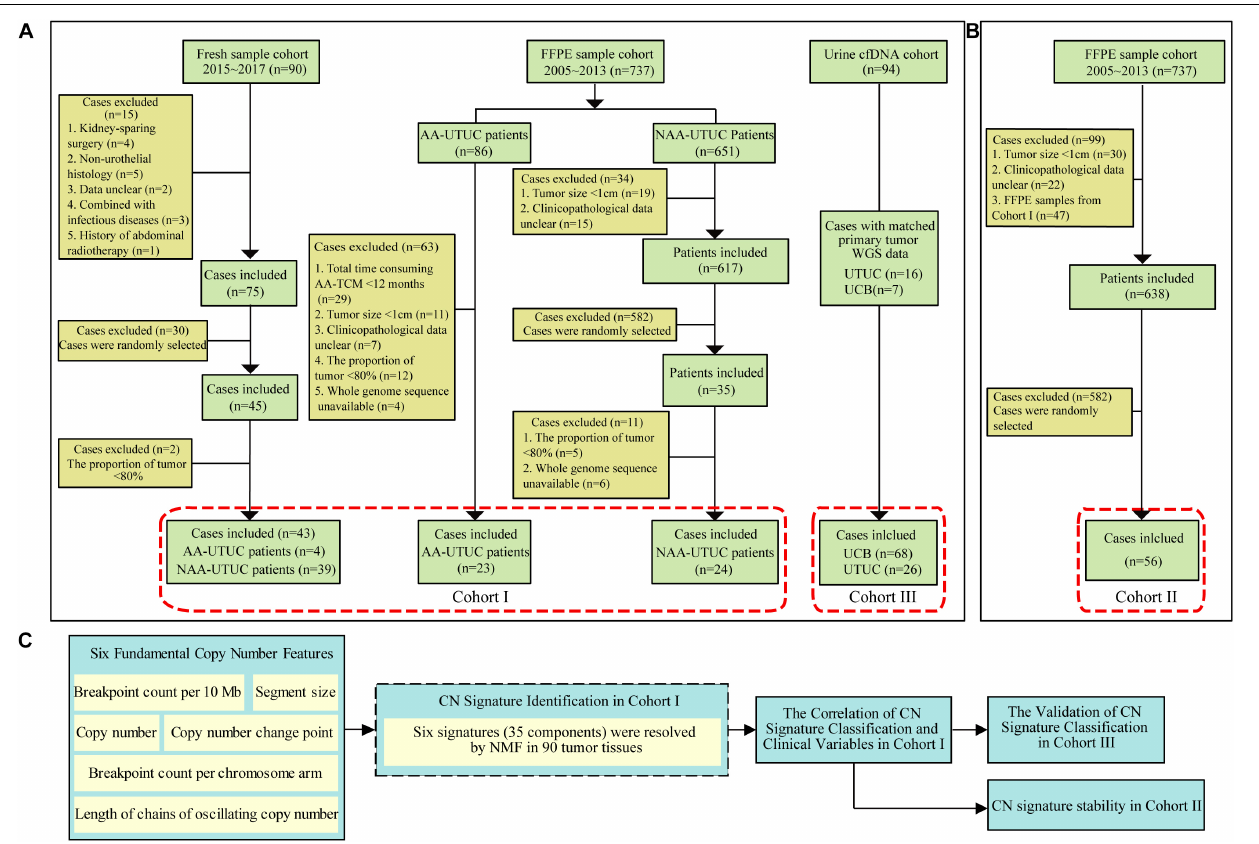
FIGURE 1 | Diagram of patient selection and analysis procedures. (A) The WGS data from two cohorts including tumor samples of 90 Chinese UTUC patients (Cohort I) and a validation cohort of 56 UTUC patients (Cohort II). (B) Ninety-four preoperative urinary cfDNA of urothelial carcinoma patients (Cohort III: 68 UCB and 26 UTUC). (C) All CN signatures identified from Cohort I were used for the extraction of CN signatures from Cohort II and III. WGS, whole-genome sequencing; cfDNA, cell-free DNA; AA, aristolochic acid; NAA, non-aristolochic acid; UTUC, upper tract urothelial carcinoma; FFPE, formalin-fixed paraffin-embedded; AA-TCM, aristolochic acid-associated traditional Chinese medicine; UCB, urothelial carcinoma of bladder; NMF, non-negative matrix factorization; TCGA, The Cancer Genome Atlas; CN, copy